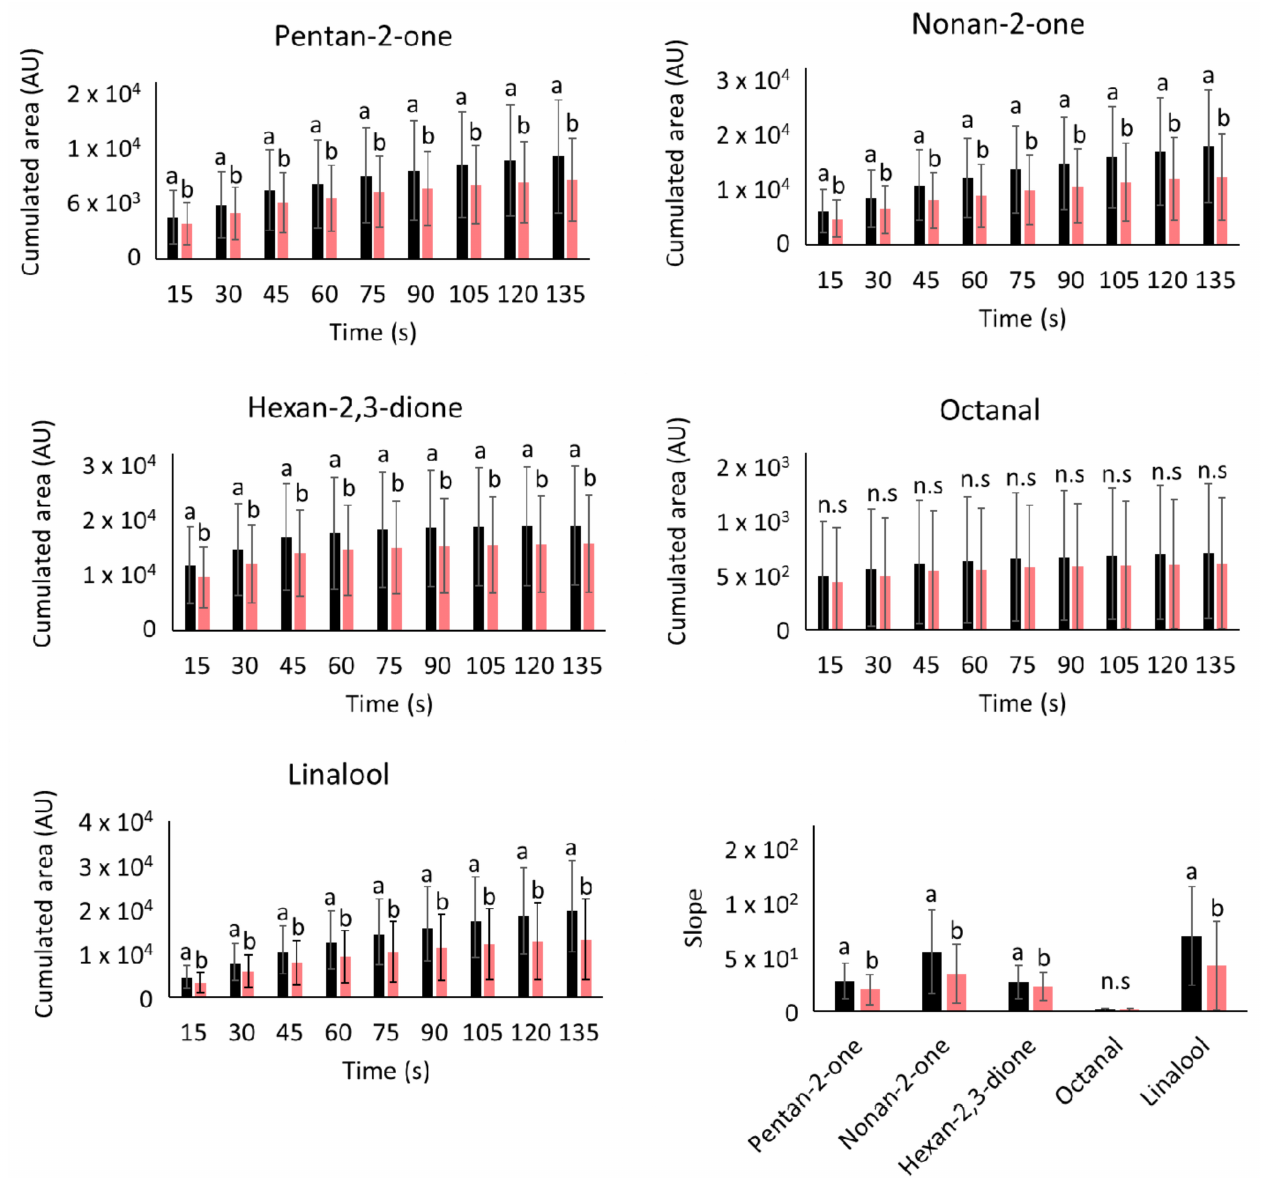
Figure 1. Effects of oligofructose on the retronasal release (cumulative area and slope) of five aroma compounds by 73 elderly individuals during consumption of a control aqueous solution (black) and an oligofructose solution (pink). Mean value ± standard deviation. Different letters (“a”, “b”) indicate significant differences among aqueous (control) and oligofructose solutions for each time slice of cumulated area (AU = arbitrary units) or for each compound regarding their slope (Tukey test, α < 0.05), and n.s., the difference was not